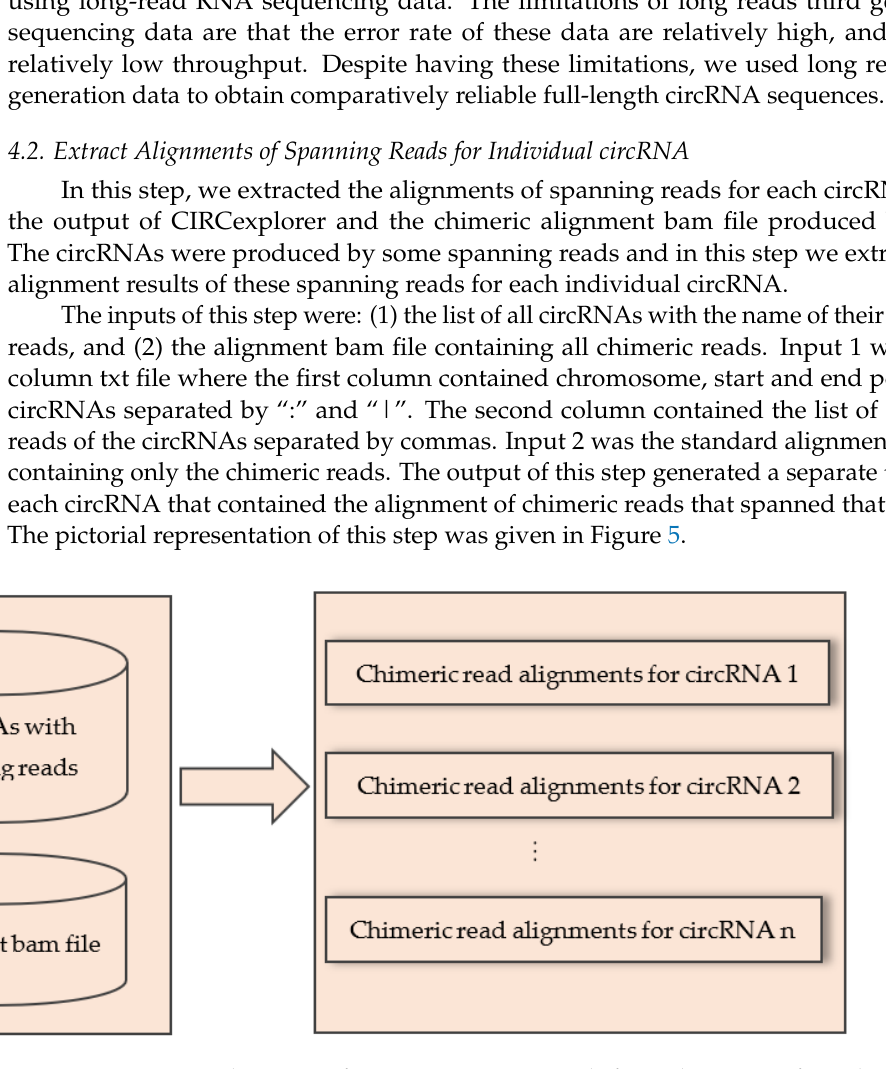
Figure 5. Extracting alignment of circRNA spanning reads for each circRNA from the alignment bam file.